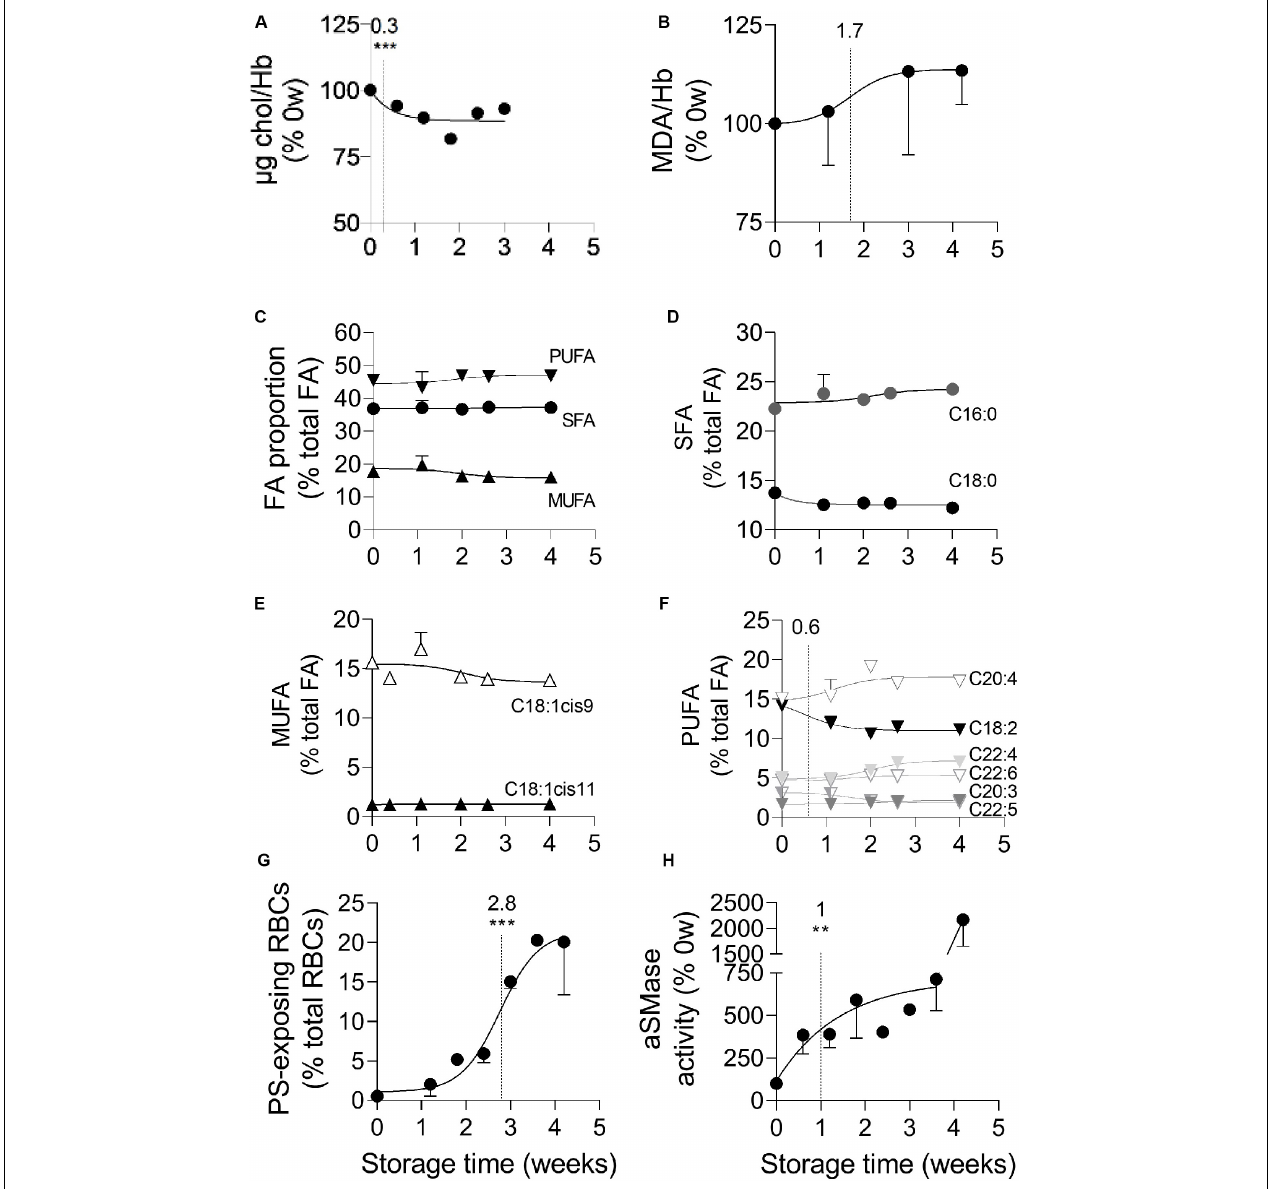
FIGURE 4 | Cholesterol and linoleic acid (C18:2) decreases, plasmatic acid sphingomyelinase activation, lipid peroxidation and PS surface exposure successively take place at the RBC membrane during storage. RBCs isolated from K + /EDTA tubes stored at 4 ◦ C were analyzed for their membrane content in cholesterol (chol, A ), peroxidized lipids (B) , fatty acids (FA; C–F ) and external phosphatidylserine (PS; G ) while isolated plasmas were assessed for the plasmatic acid sphingomyelinase (aSMase) activity (H) . The time needed to reach 50% effect and the corresponding statistical analysis (Mann–Whitney U test) are indicated above the vertical dotted line. (A) Chol content. Chol was quantified based on successive enzymatic reactions leading to the production of H 2 O 2 which allows the transformation of non–fluorescent Amplex Red into fluorescent resofurin measured at 585 nm. Data were normalized to the Hb content and expressed in % of 0 week of storage. Means ± SEM of 4 independent experiments. Error bars were included in the symbols. (B) Malondialdehyde (MDA) content. Lysates of isolated RBCs were incubated with thiobarbituric acid (TBA) which reacts with free MDA, one of the end products of lipid peroxidation, to form a fluorescent adduct measured at 553 nm. Data were normalized to the Hb content and expressed in % of 0 weeks of storage. Means ± SD of 2 independent experiments. (C–F) FA composition. Total lipid extraction from isolated RBCs was followed by methylation and extraction of FA methyl esters and analysis by gas chromatography. All data are means ± SD of triplicates from 1 representative experiment out of 2 and are expressed as % of total FAs. (C) Proportion of saturated fatty acids (SFA), mono- (MUFA) and poly-unsaturated fatty acids (PUFA). (D) Relative proportion of the two major SFAs (C16:0 and C18:0). (E) Relative proportion of the two major MUFAs (i.e., C18 with one double bond either on position 9 or 11). (F) Relative proportion of the major PUFAs (chains of 18–22C and 2–6 double bonds). (G) Exposure of PS at the RBC surface. RBCs were labeled with Annexin-V coupled to FITC and then analyzed in flow cytometry. The % of Annexin V-FITC positive RBCs was determined by positioning the cursor at the edge of the labeled cell population at 0 weeks of storage. Data are means ± SEM of 3 independent experiments. (H) aSMase activity. The activity of aSMase in isolated plasmas was measured thanks to successive enzymatic reactions leading to the formation of a fluorescent product, the resorufin, measured at 585 nm. Means ± SEM of 5 independent experiments. ** p < 0.01; *** p < 0.001.